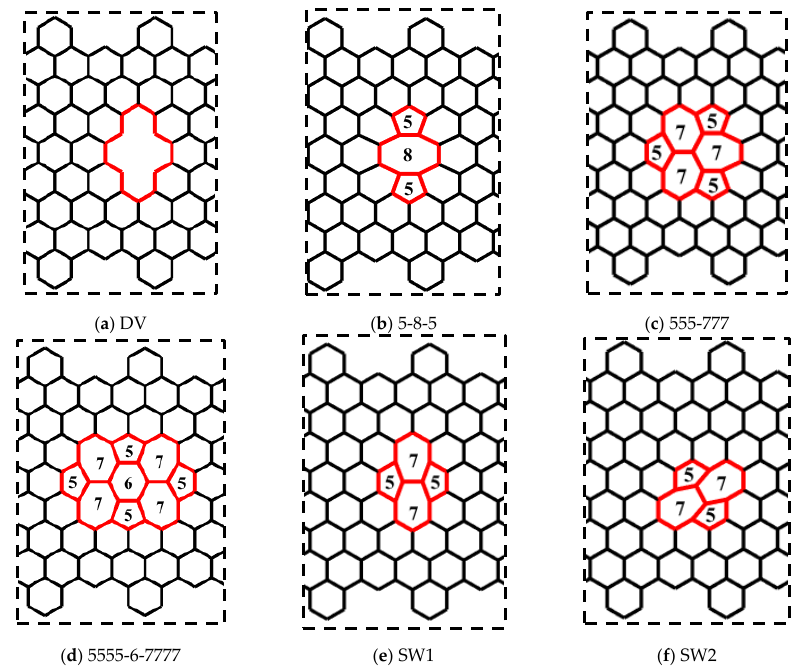
Figure 8. Topological and vacancy defects embedded in CGNR.